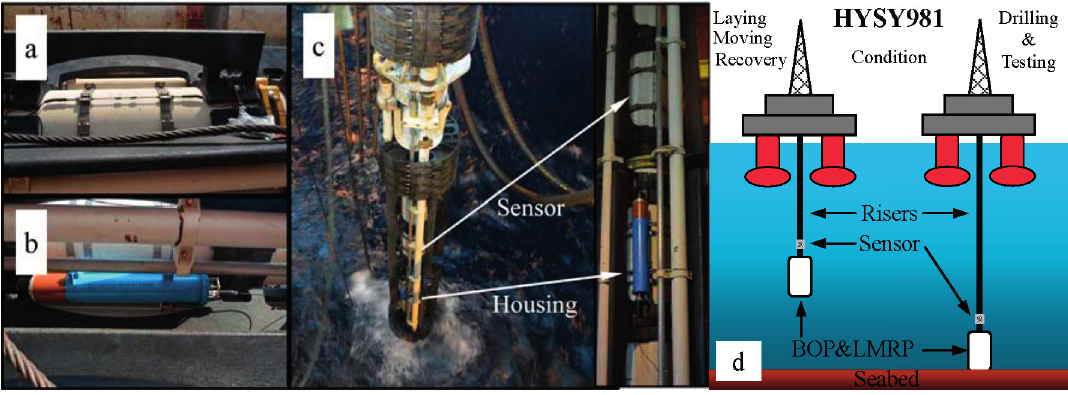
Figure 3. The sensor system assembled on a riser. ( a ) Assembled connected sensors and ties; ( b ) assembled housing; ( c ) close-up of the sensor system lowered into water; ( d ) working conditions schematic of the ocean oil drilling platform